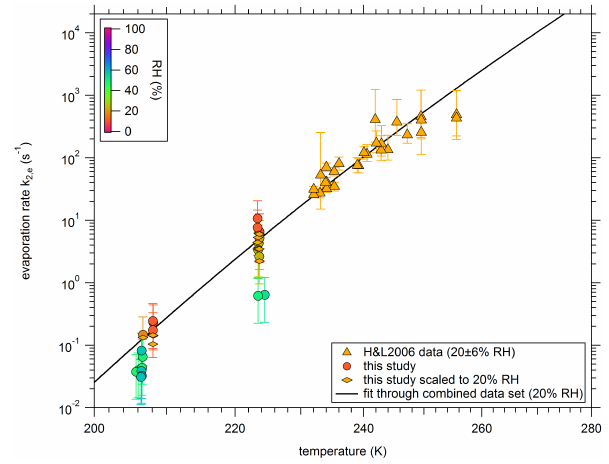
Figure 7. Comparison of the sulfuric acid dimer evaporation rates from this study (circles) and from the literature (triangles; see Han- son and Lovejoy, 2006) as a function of temperature. The color code indicates the relative humidity during the experiments. Diamond symbols represent the data from this study scaled to 20% RH. The solid line shows a best fit through the data with the thermodynamic properties d H = − 20 . 1 ± 1.2 kcal mol − 1 and d S = − 46 . 7 ± 5.2 cal mol − 1 K − 1 at 20%